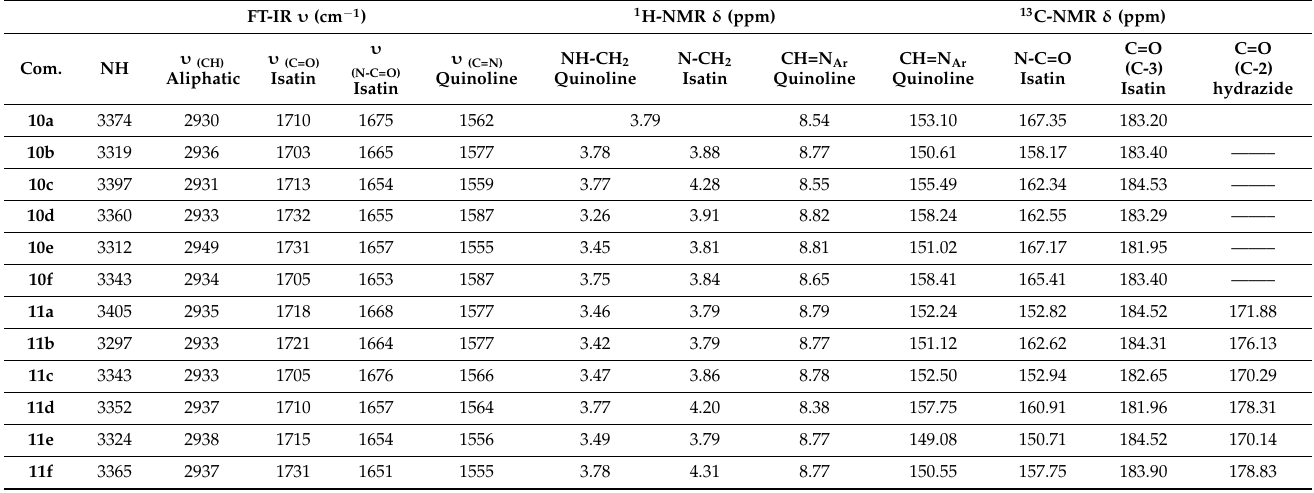
Table 1. Spectral data for conjugates 10a – f and 11a – f